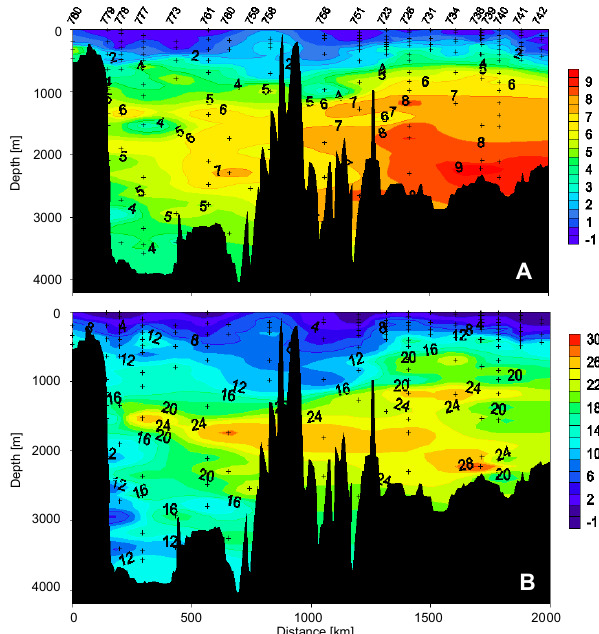
Fig. 11. Terrigenic He in percent of the He solubility equilibrium values (A) and tritium- 3 He age ( B ; years) in the EMed for cruise M5/6, 1987; for track see Fig. 7. Station numbers at top of figure, dots indicate data